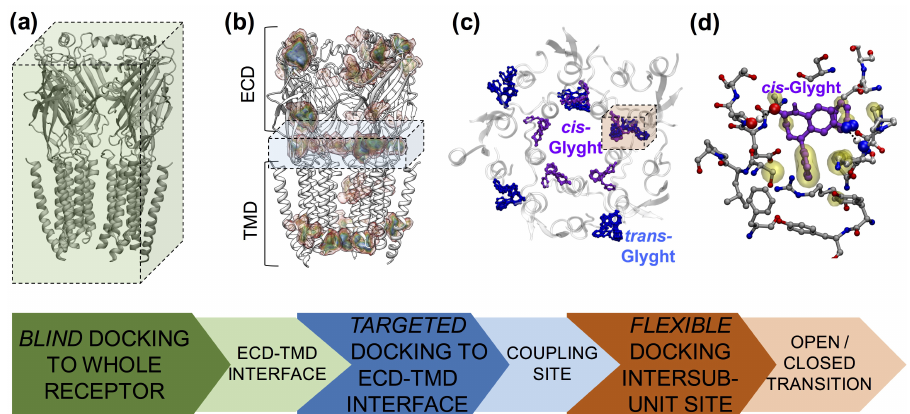
Figure 8. Multilevel docking screening to identify and characterize the binding site of Glyght in GlyR. ( a ) Blind docking of Glyght to the cryo-EM structure of α 1 GlyR [109]. For the sake of clarity, the front subunit is not shown. The box size used for the blind docking calculation, encompassing the whole receptor, is shown as a green box. ( b ) Density map of the ligand poses of cis -Glyght obtained in the blind docking. Each contour line corresponds to a number density of 0.0006 particles/Å 3 . Among the several high-density regions, the interface between ECD and TMD appears to be the most likely binding region for cis -Glyght [114], as it shows the largest differences compared to the trans - Glyght blind docking (data not shown). The box size for the subsequent targeted rigid docking is indicated as a blue box. ( c ) Docking poses obtained by rigid docking focused on the ECD–TMD interface. The five α 1 GlyR subunits are represented in ribbons and colored in white, whereas the most populated ligand poses of cis - (violet) and trans -Glyght (blue) are shown as ball and sticks. The box size for the subsequent flexible docking is indicated as an orange box. ( d ) Detailed view of the cis -Glyght binding pose obtained by flexible docking centered at the ECD–TMD interface site. Hydrophobic contacts between cis -Glyght and the receptor residues are represented as a yellow surface, while the atoms involved in receptor–ligand hydrogen bonds are represented with larger spheres and a dashed line between them. Adapted from reference [114] with permission from Cell Chemical Biology, published by Elsevier